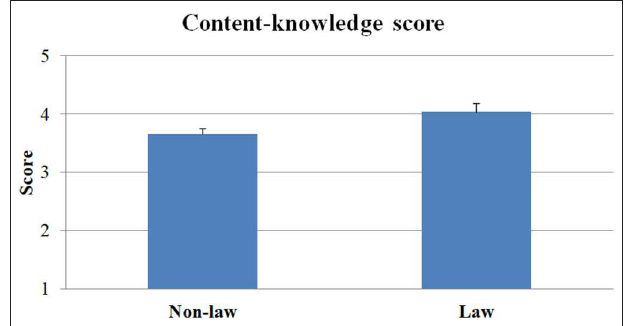
FIGURE 1 | Mean differences in content-knowledge score between non-law and law students.